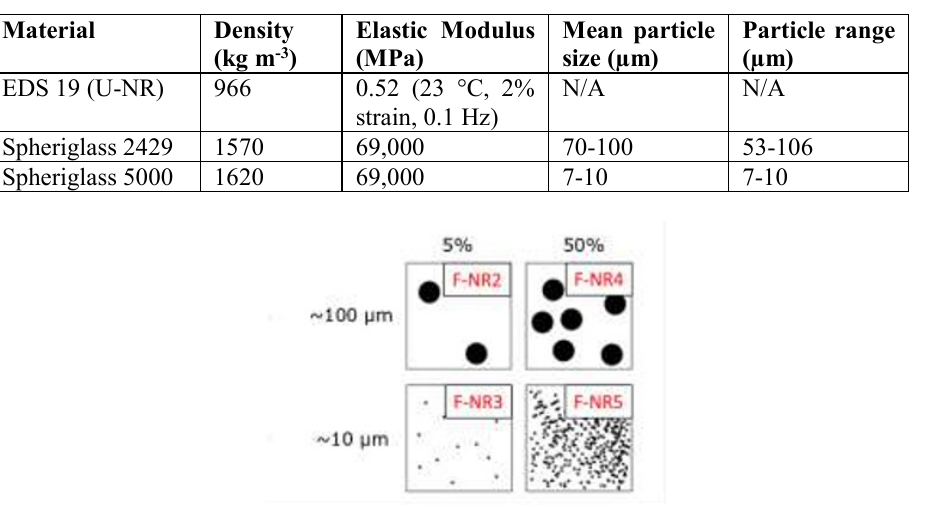
Figure 1. Schematic diagram of the different grades of F-NR composites.